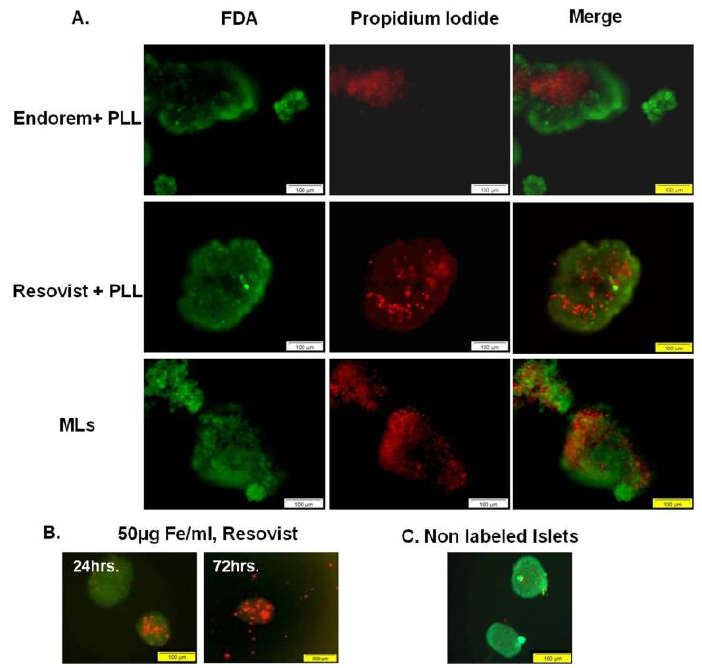
Figure 4. Islet viability: None of the SPIOs showed negative effects on the viability of islet cells (FDA/propidium iodide staining) after labeling. ( B ) In order to generate magnetic resonance (MR)-detectable uptake by using Resovist, without addition of PLL, 72 h of incubation was necessary. But severe effects on the islet viability were observed after such prolonged incubation times. ( C ) Non-labeled islets immediately after isolation. Scale bar: ( A , B ) 100 μm, ( C ) 200 μm.